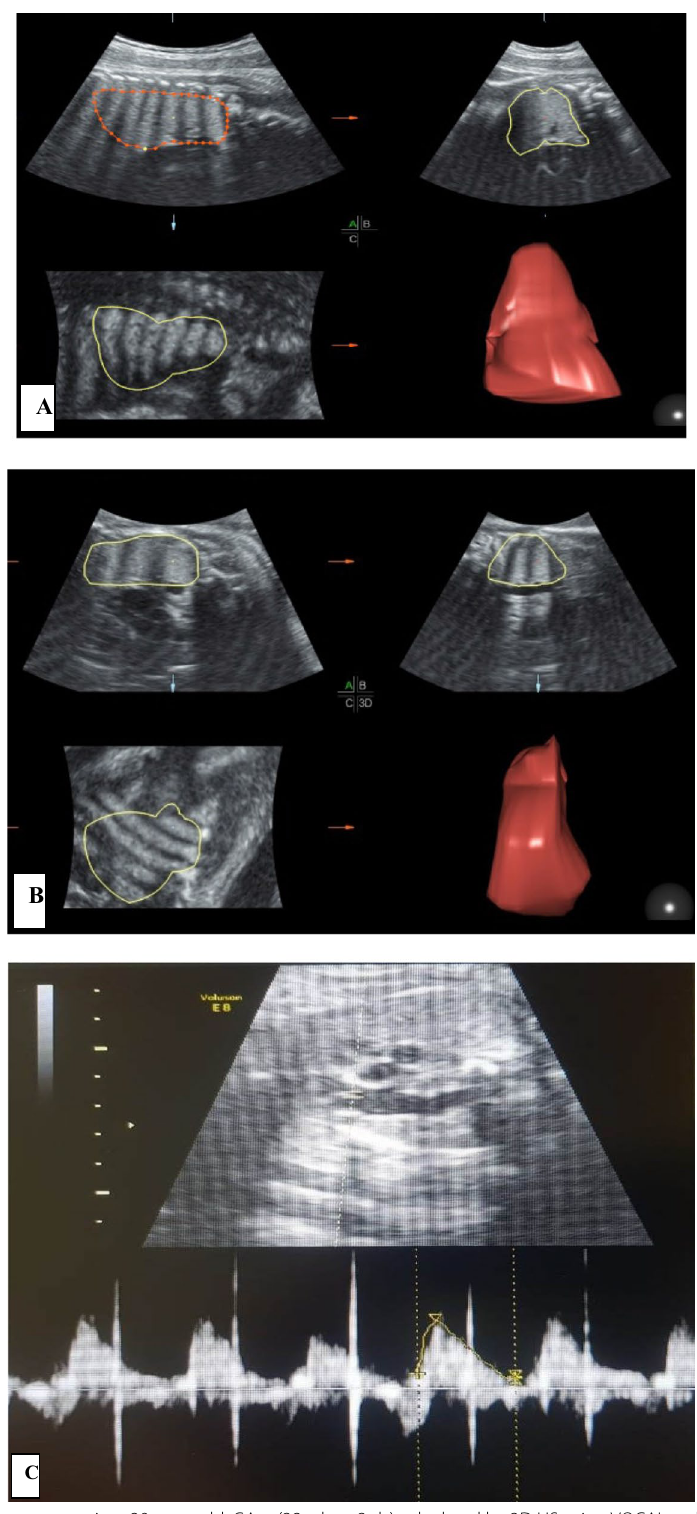
Fig. 3 A – C Lung volume of pregnant patient 29 years old, GA of right lung ( A ) and left lung ( B ) 30 cm 3 and 28 cm 3 , respectively. C The pulmonary artery resistance index (RI) of the same patient measured by pulsed Doppler RI 0.84. (RD neonate admitted to =